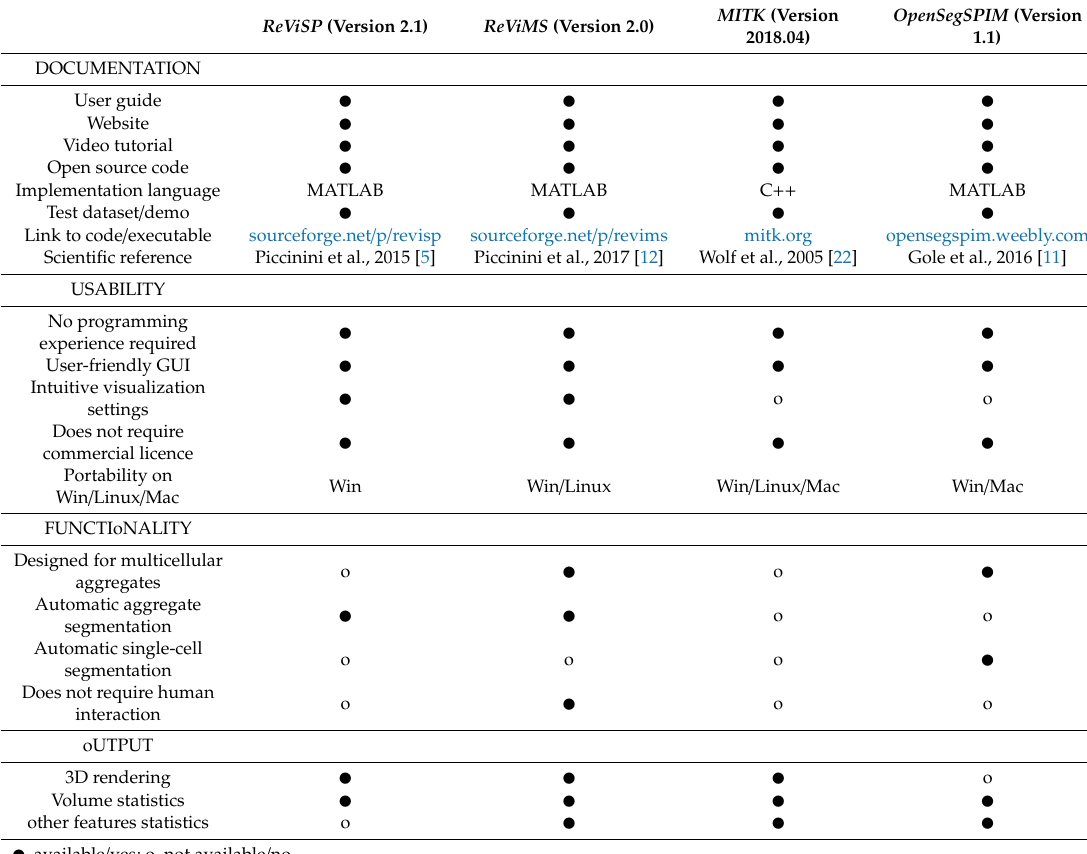
Figure 4. Flow-chart helping to define an appropriate open-source tool according to the characteristics of the used 3D in vitro model. ReViSP can be used just to estimate the total volume of a spheroid and it requires a single 2D image as input. If there is an interest in the volumes of the single cells composing the cell aggregate , OpenSegSPIM and MITK are available. Otherwise, ReViMS is the suggested tool. It is worth noting that OpenSegSPIM , MITK , and ReViMS require a 3D image as input. Table 3. Suggested volume-estimation tools comparison.